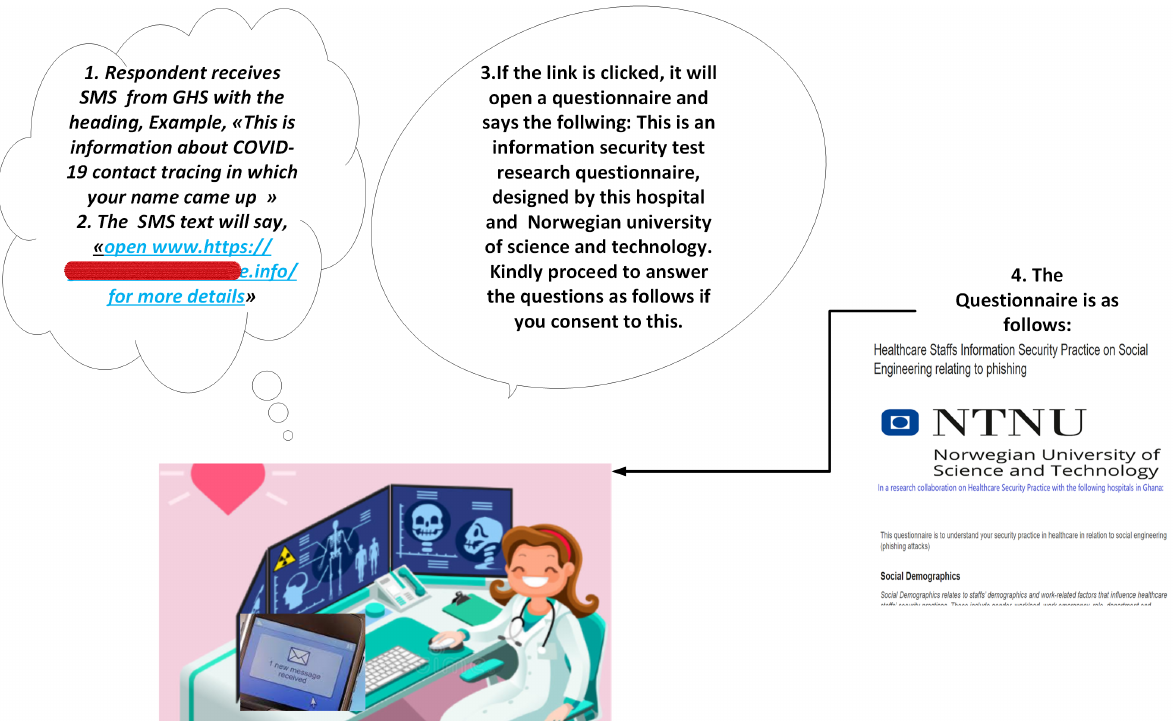
Figure 4. Framework for SMS-based phishing